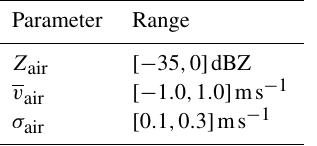
Table 2. Input settings for the Monte Carlo simulation. The values are based on the clear-air properties of the RWP peak. Square brack- ets denote the range from which the random numbers are